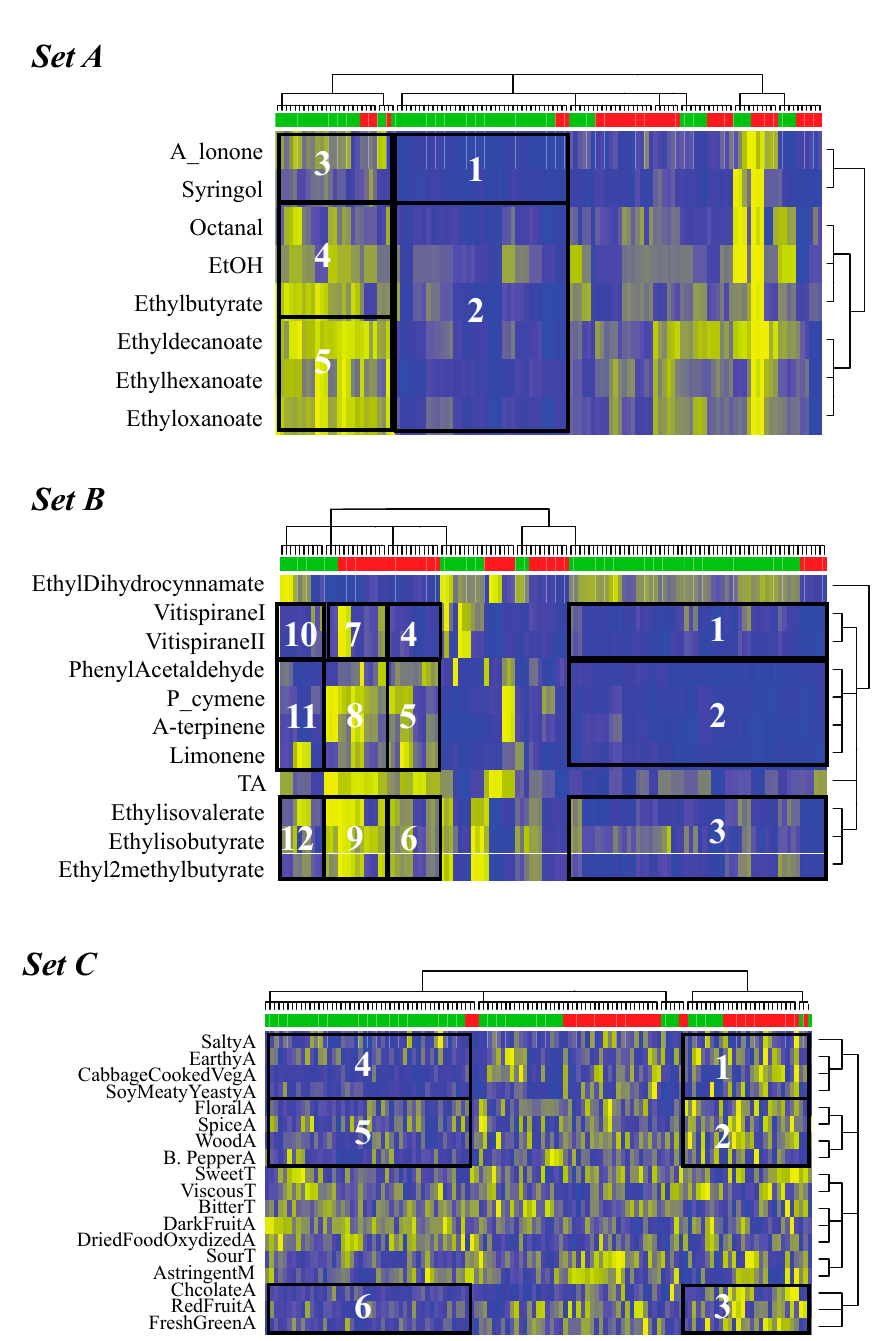
Figure 2. Clustering Californian and Argentinean Malbec wines. The 45 Californian wines and 78 Argentinean wines are clustered using Data Mechanics on three different sets of wine characteristics, ( A – C ) that are described in Figure 1. The corresponding heat maps have wines as rows, and wine characteristics as columns. For clarity, wines from California are shown in red, and wines from Argentina in green. The links between the hierarchical trees on the wines and on the characteristics reveal bi-clusters, i.e., groups of wines that are associated with groups of features, as illustrated with the boxed regions labeled with numerals on the three heat maps. The color scale blue to yellow used to represent the heat maps corresponds to the interval [1,10] for the digital scores (see text for details on those digital score, with blue mapping to 1 and yellow to